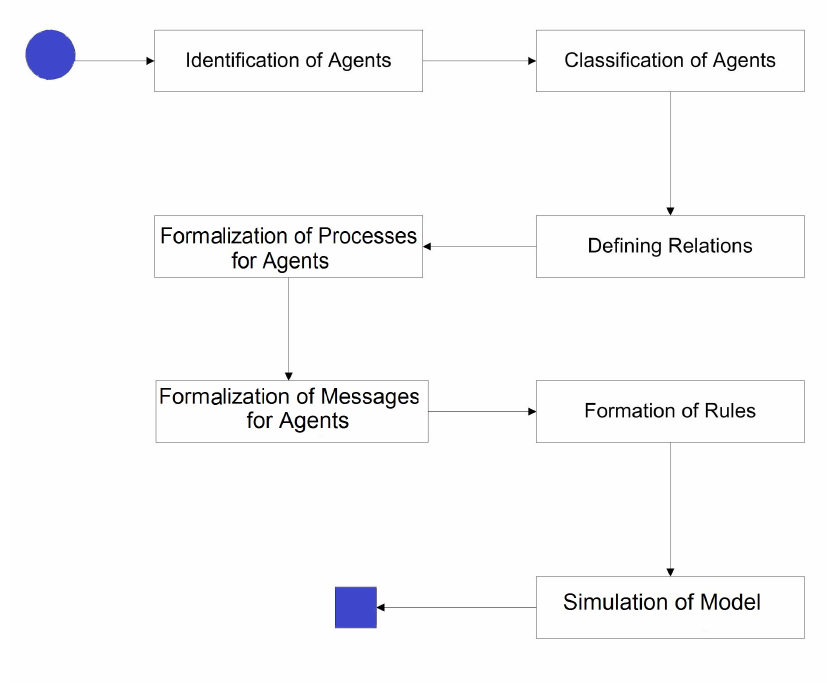
Figure 2. Integrated framework flow